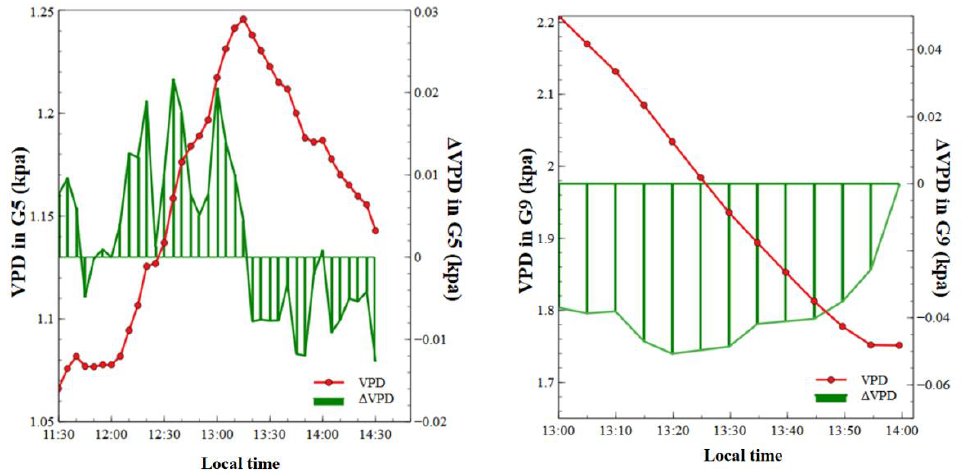
Figure 14. VPD and ∆ VPD values of G5 and Figure 14. VPD and ΔVPD values of G5 and G 9.